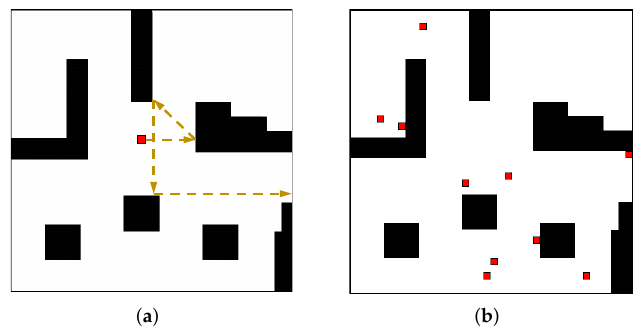
Figure 9. The diagram of the initial distribution of moving obstacles and their movement trajectory. The red cells represent the dynamic obstacles, and the yellow dotted line represents the possible movement trajectory of this obstacle in left figure. When the environment is initialized, moving obstacles are randomly generated in the blank area of the map, and each obstacle is independent of each other. The right figure shows the initialization of the moving obstacles.